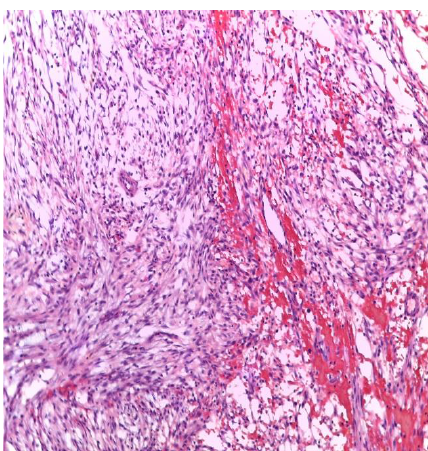
Figure 5. Histologic finding that shows characteristic aspects of nodular fasciitis: sheets and bundles of spindle cells with cystic myxoid changes and extravasated erythrocytes (H&E × 100). Three months after surgery, an MRI with and without contrast was performed on the patient that confirmed the complete resection of the lesion without any recurrence. The last follow-up (12 months after resection) showed no recurrence.